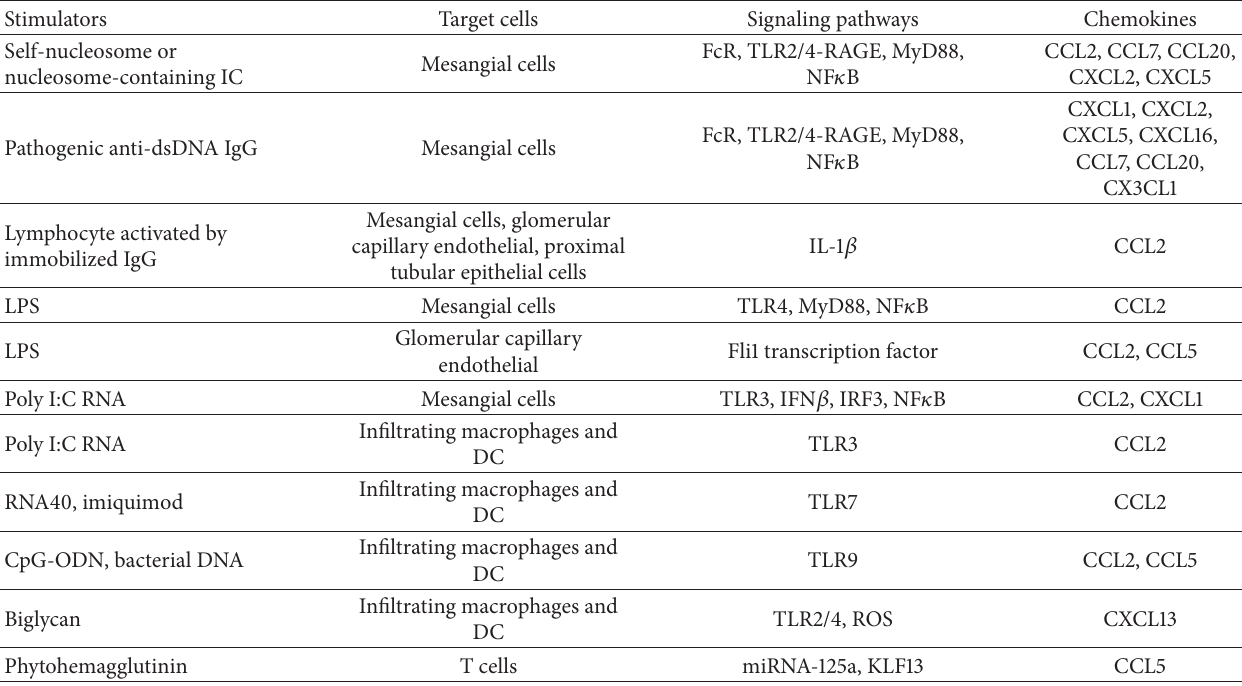
Table 3: Mechanisms of chemokine induction in lupus nephritic